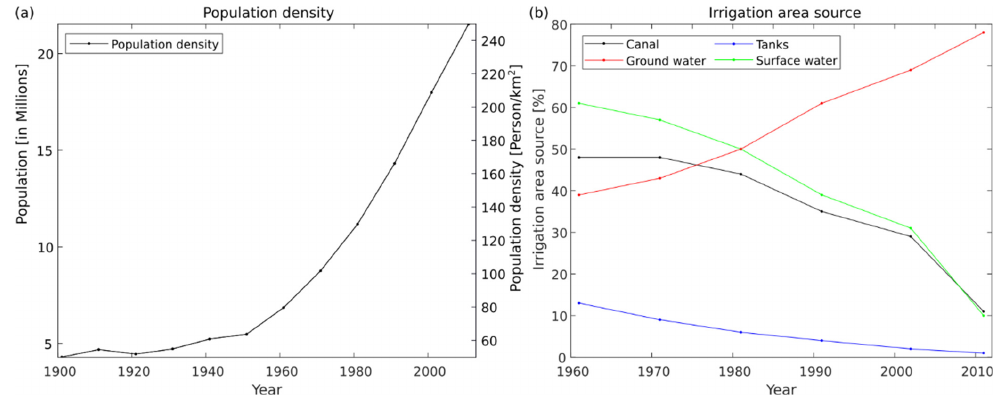
Figure 13. ( a ) Census population data from 1901 to 2011 of the Betwa region districts. ( b ) Irrigation area in percentage from the canal, tanks, groundwater, and surface water sources (Source: MPKrishi.mp.gov.in (accessed on 20 June 2022)).